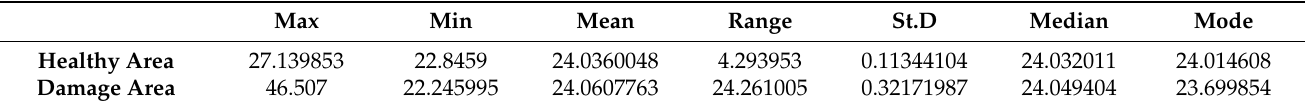
Table 7. Statistical results for thick samples based on reflection mode.